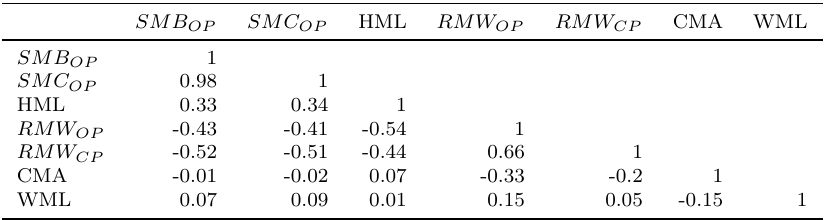
Table 4: Correlation Matrix of